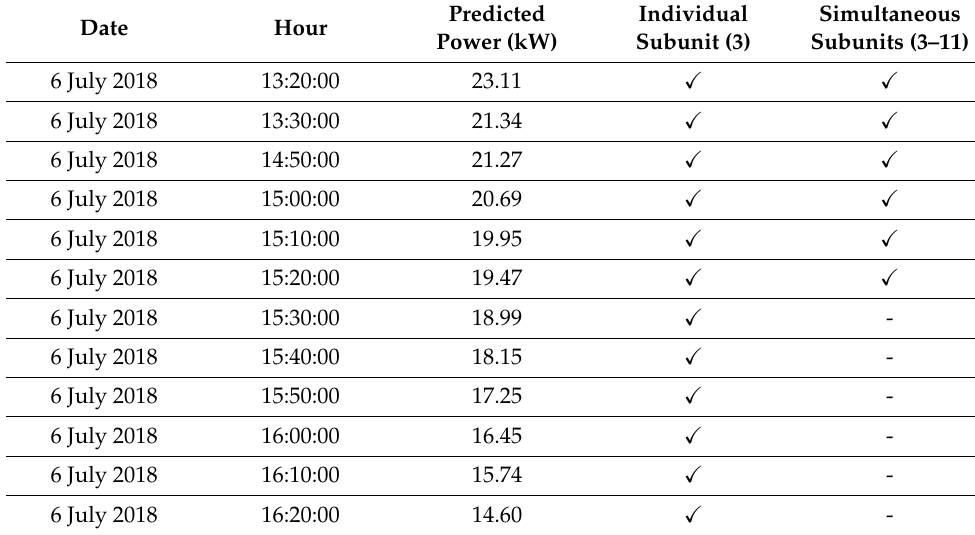
Table 4, the farmer could only irrigate subunits 3 and 11 from 13:20:00 to 15:20:00 hours. Table 4. Predicted power obtained with the PREPOSOL